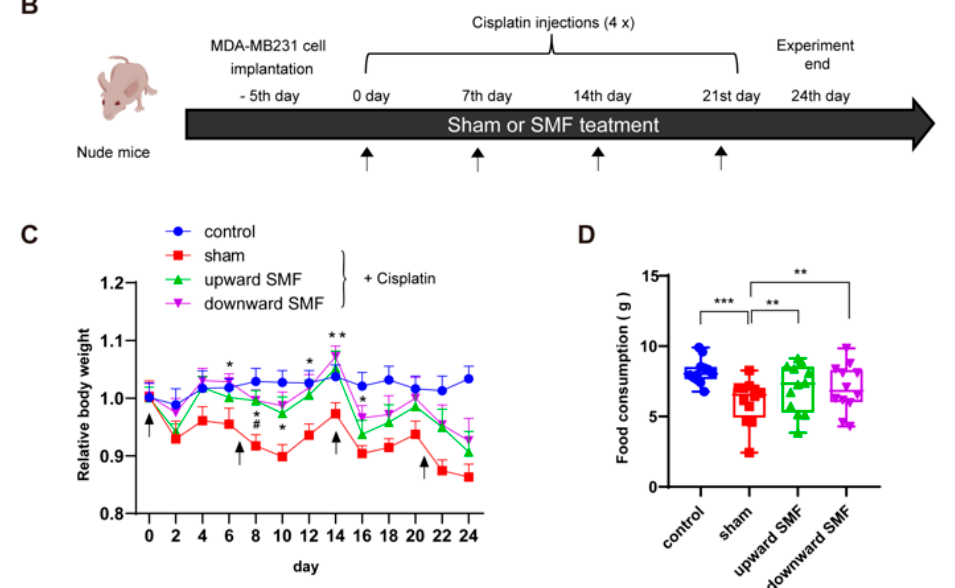
Figure 2. SMFs alleviate cisplatin-induced body weight loss in tumor-bearing mice. ( A ) Magnetic plates providing quasi-uniform SMFs with different directions were used in the animal studies. Schematic illustration of the experimental set up and magnetic flux density distribution at 2.5 cm above the magnetic plates are shown. The SMFs at the mice’s bodies are ~70–220 mT from head to toe. ( B ) Flow chart of the experimental procedure for mice. The relative body weight ( C ) and food consumption ( D ) were measured every two days. There were six mice in each group. Data are represented as means ± SD. * p < 0.05, ** p < 0.01, *** p < 0.001. In ( C ), * p < 0.05, ** p < 0.01, sham versus downward direction SMF group; # p < 0.05, sham versus upward direction SMF